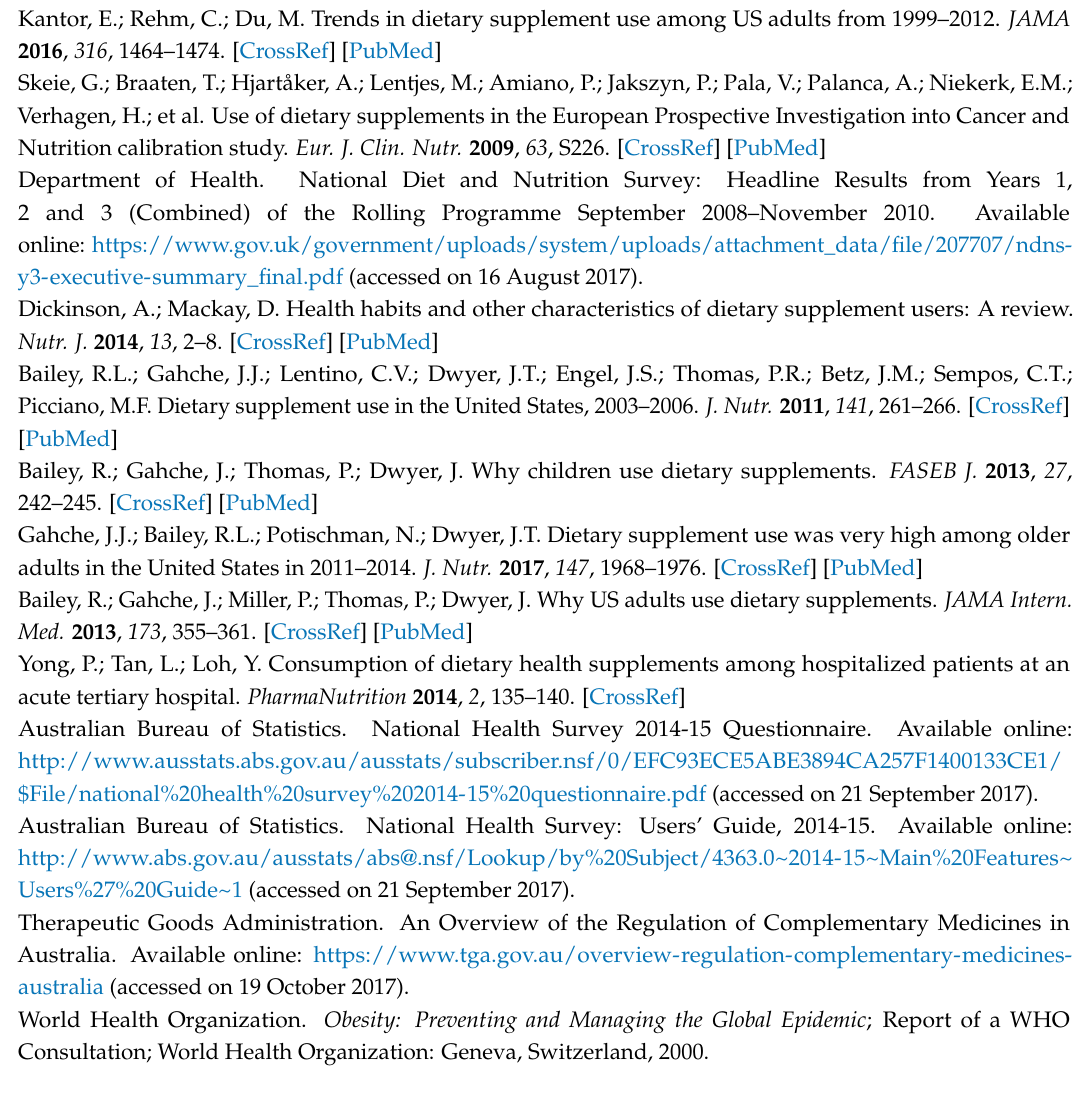
Supplementary Table S1: Supplement categories, Supplementary Table S2: Characteristics of supplement users Supplementary Table S3: Characteristics of supplement users and non-users among adolescents aged 10–17 years participating in the 2014–2015 National Health Survey ( n = 1964), Supplementary Table S4: Characteristics